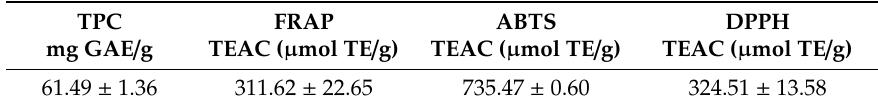
Table 8. Total Antioxidant Capacity (TAC) and antioxidant activities determined according to the FRAP, ABTS, and DPPH methods of spent co ff ee extract obtained using the desirability function